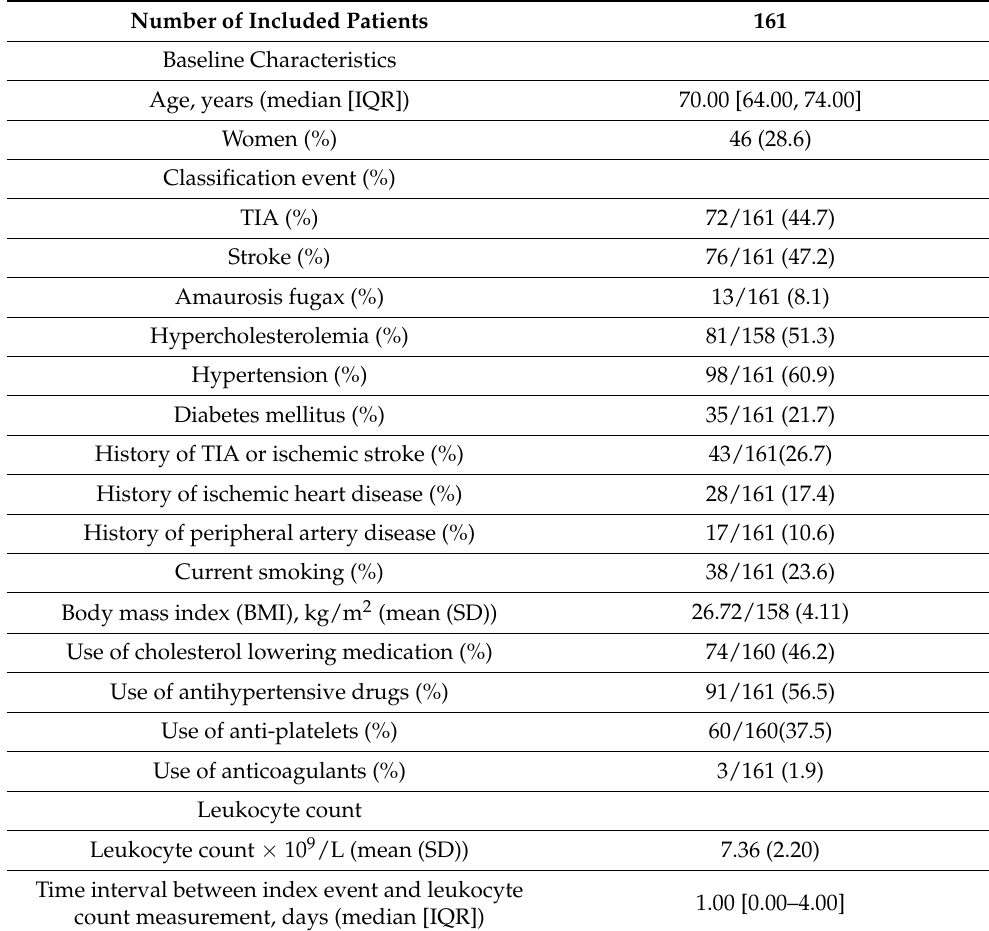
Table 1. Baseline characteristics—median values with interquartile range (IQR), means with standard deviation (SD) or number with percentage when appropriate.